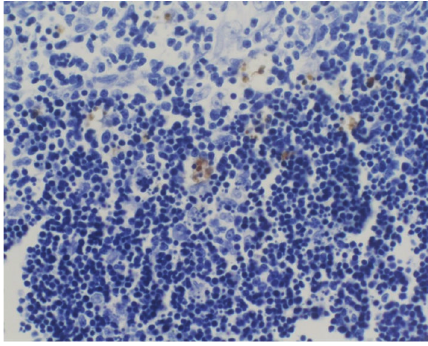
Figure 3: Sham operation group: 12 hours; Tunel × 200.